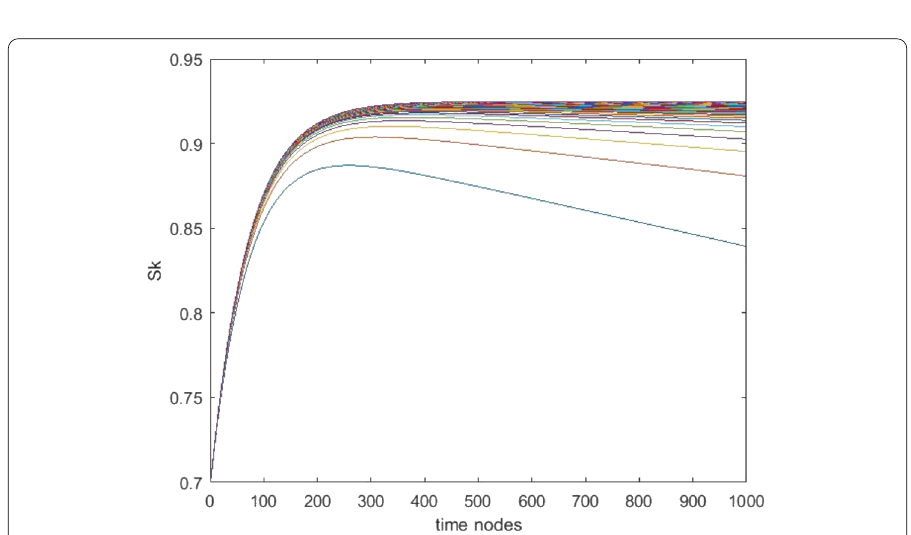
Figure 2 Evolution of the state S k for system (3) at different